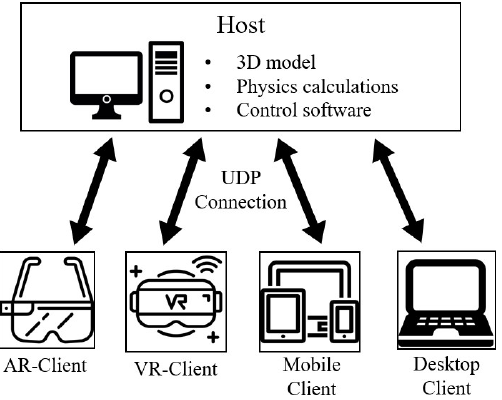
Figure 1. Architecture of the collaboration environment [5] (p. 5).